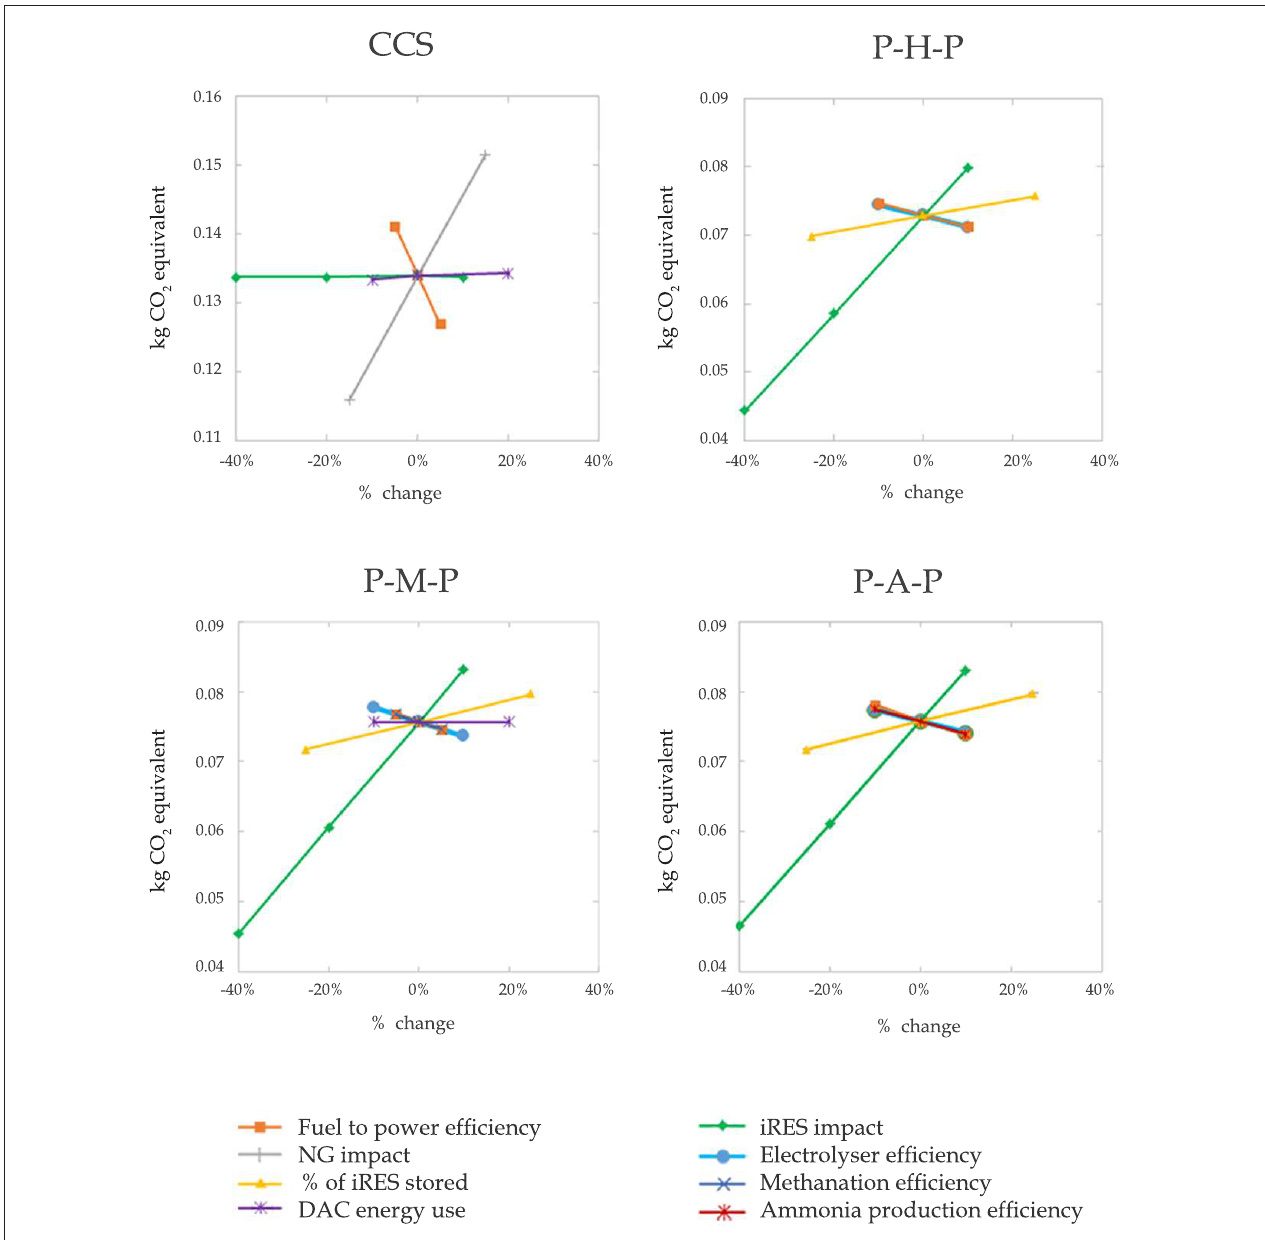
FIGURE 11 | Sensitivity analysis of climate change impact for the CCS, P-H-P, P-M-P, and P-A-P systems to several system